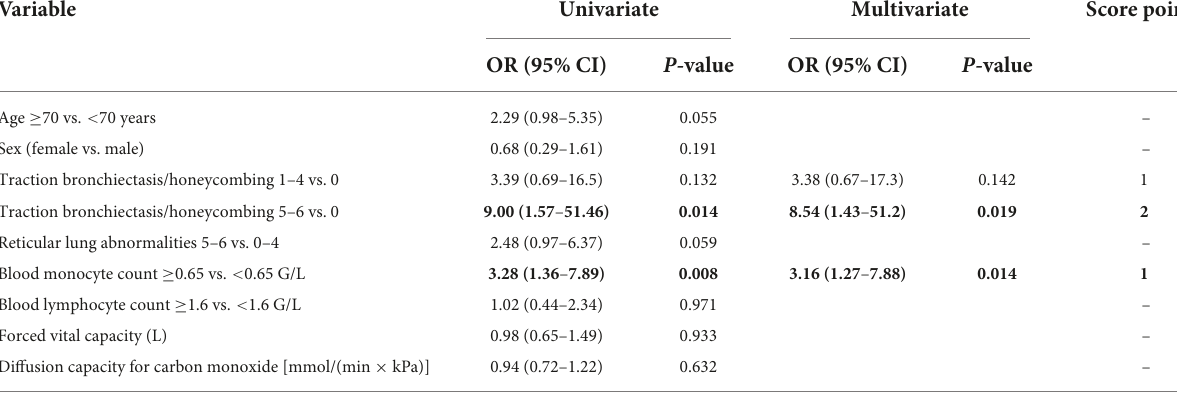
TABLE 4 Uni- and multivariate models for progression at 1 year and scoring of significant variables. Variable Univariate Multivariate Score points OR (95% CI) P -value OR (95% CI) P